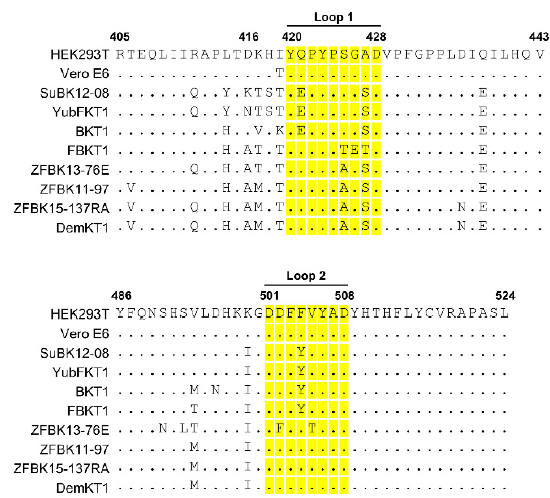
Figure 2. Comparison of amino acid sequences of Niemann–Pick C1 (NPC1) of bat NPC1 orthologues. The deduced amino acid sequences of NPC1-C of SuBK12-08, YubFKT1, BKT1, FBKT1, ZFBK13-76E, ZFBK11-97, ZFBK15-137RA, and DemKT1 are aligned. The amino acid positions of loop 1 and loop 2 are highlighted in yellow.